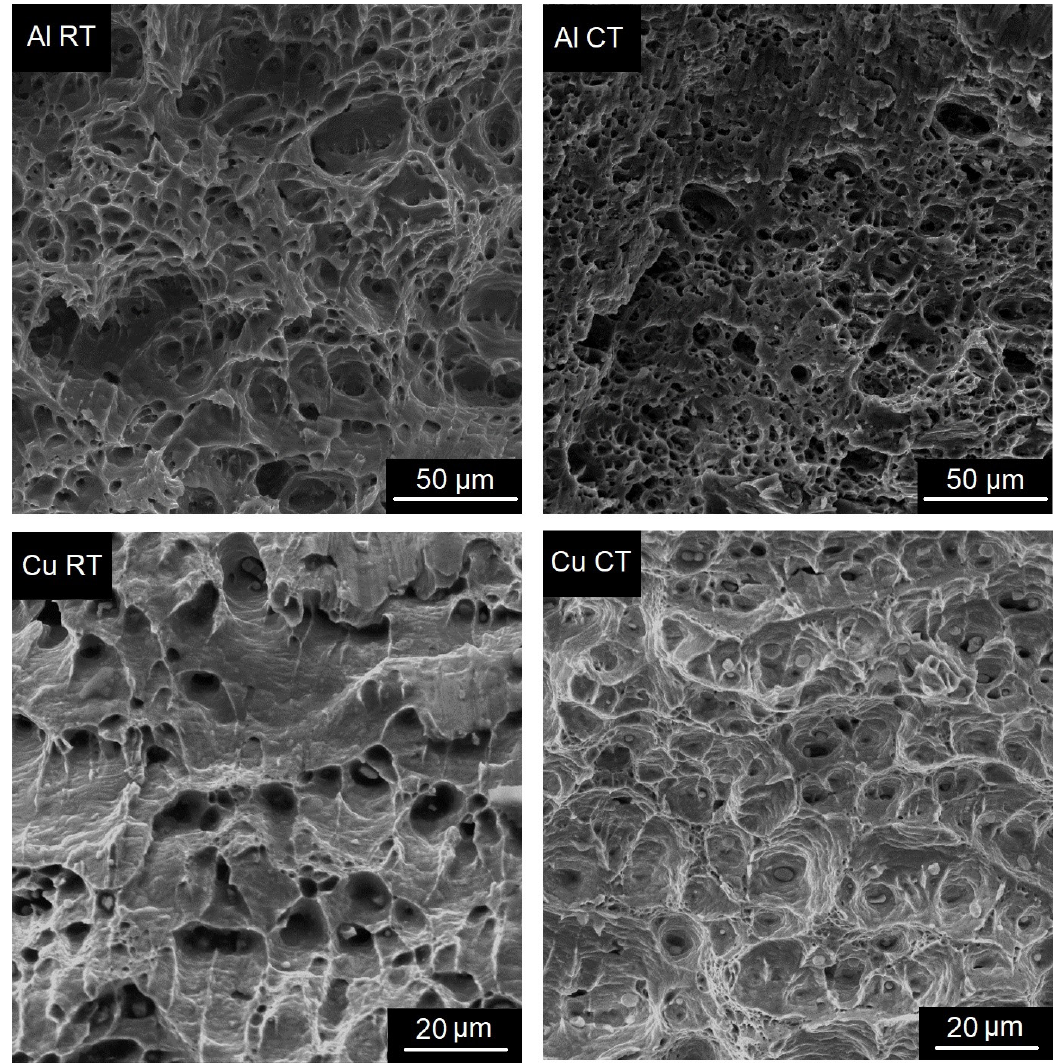
Figure 6. SEM fractographies for cp Al and cp Cu samples tested at RT and CT. Both at RT and CT, fracture surfaces are mainly composed of dimples. At CT, the fracture surface dimples are smaller for both